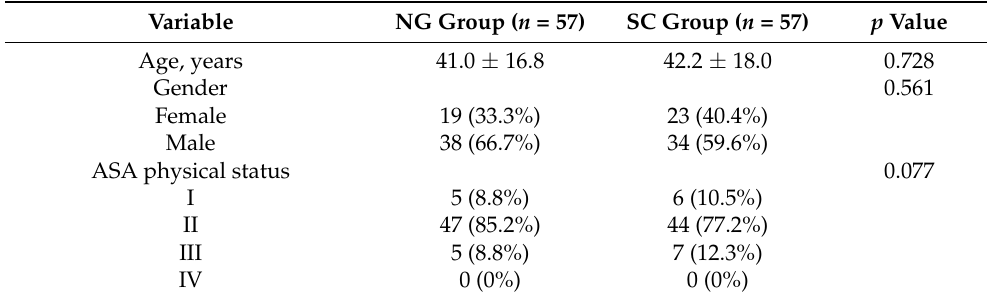
Table 1. Patient demographics, pre-operative airway examinations, and intubation